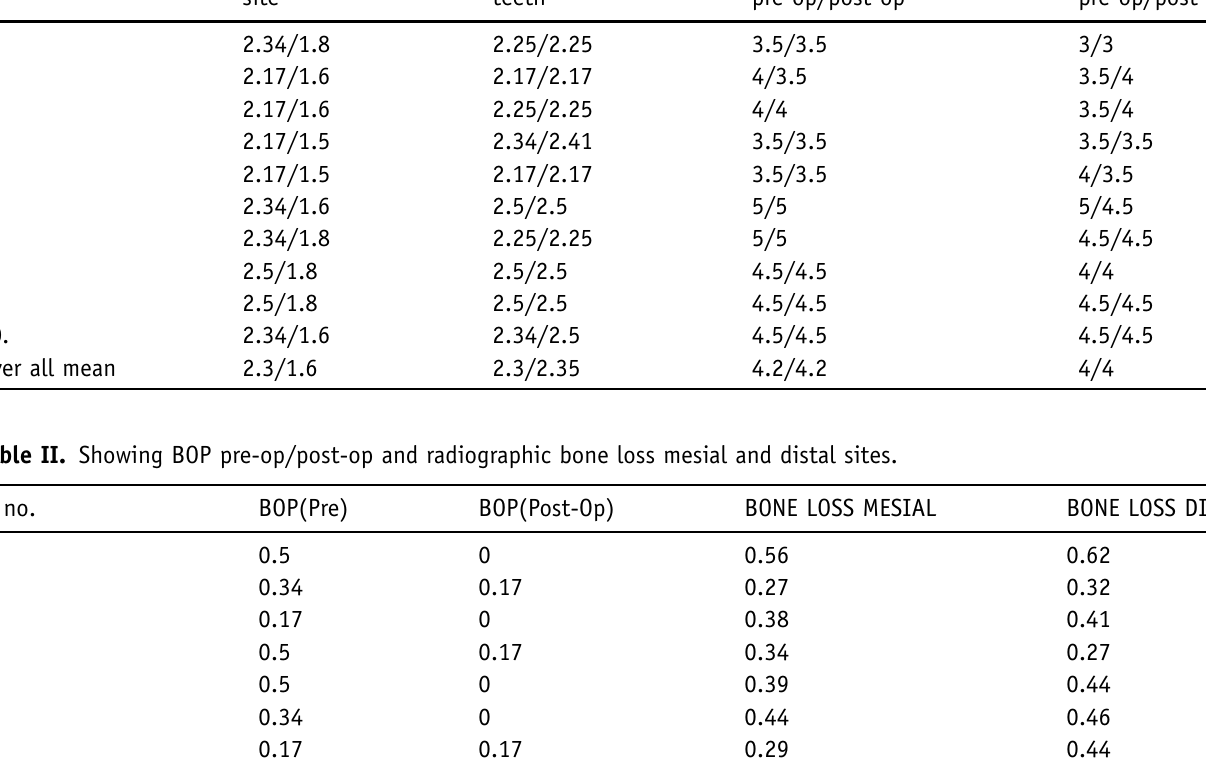
Table I. Showing PPD and BWK at implant site and adjacent teeth between pre-op and post-op 4th Year visit. S. no.